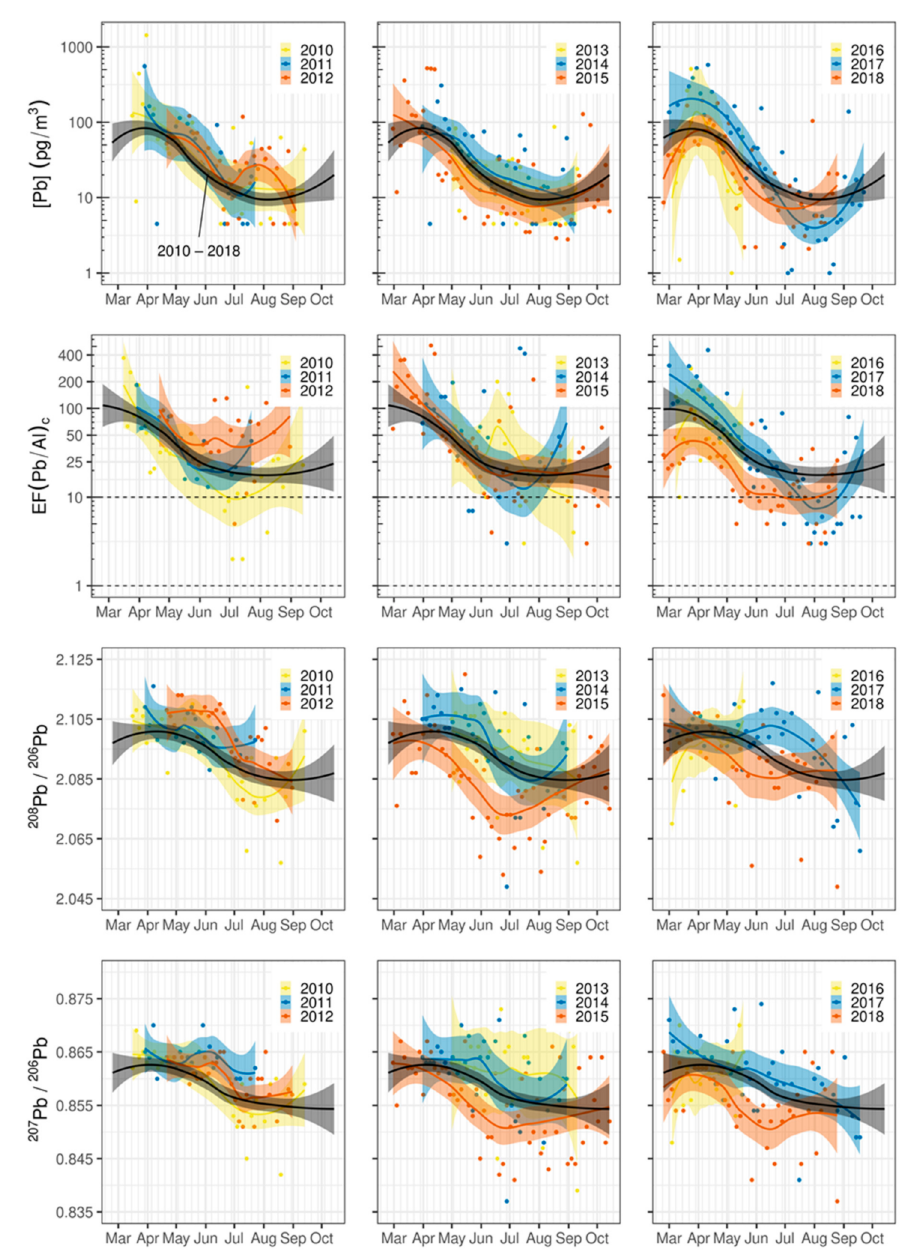
Figure 3. Time series for Pb concentrations, enrichment factors (EFs) and 208 Pb/ 206 Pb, 207 Pb/ 206 Pb isotope ratio values measured in PM 10 samples at Ny-Ålesund from 2010 to 2018. Solid lines are calculated by locally estimated scatterplot smoothing (loess) and black solid line represent the smoothed time series for the period